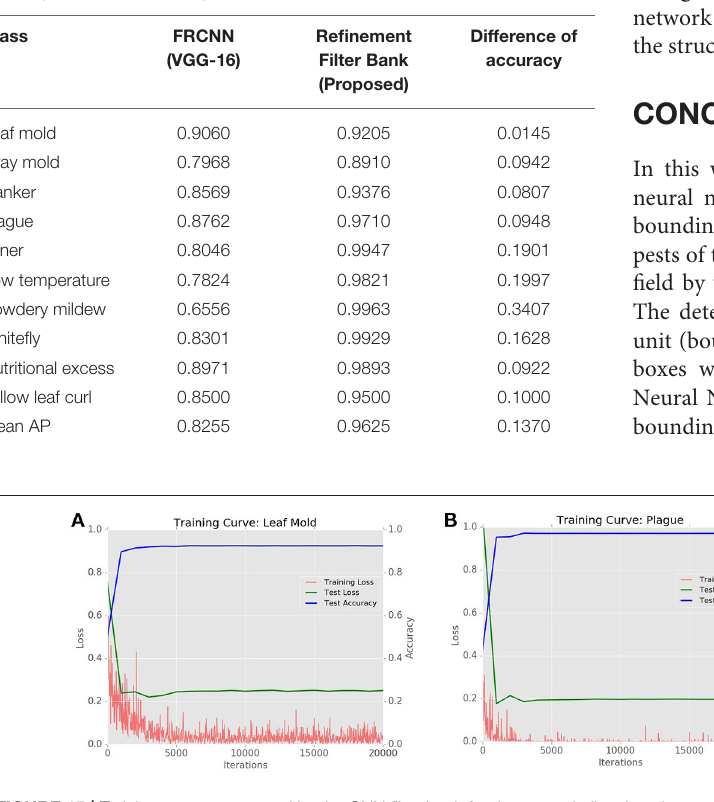
Frontiers in Plant Science |